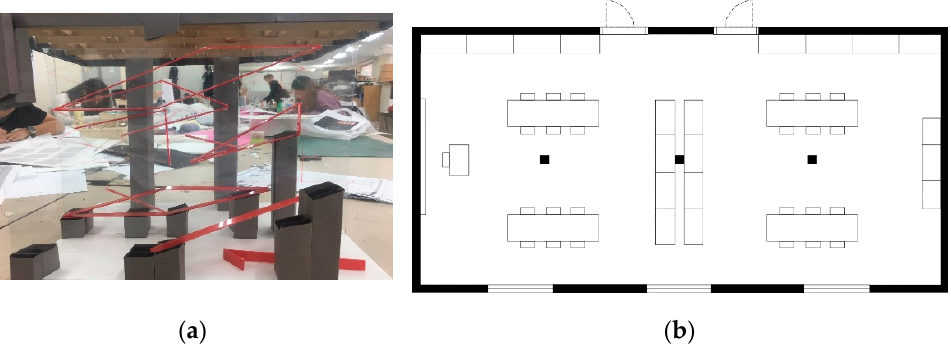
Figure 1. The view of the first-year design studio. ( a ) A group of students share the working table together. ( b ) Drawing of the studio space plan.